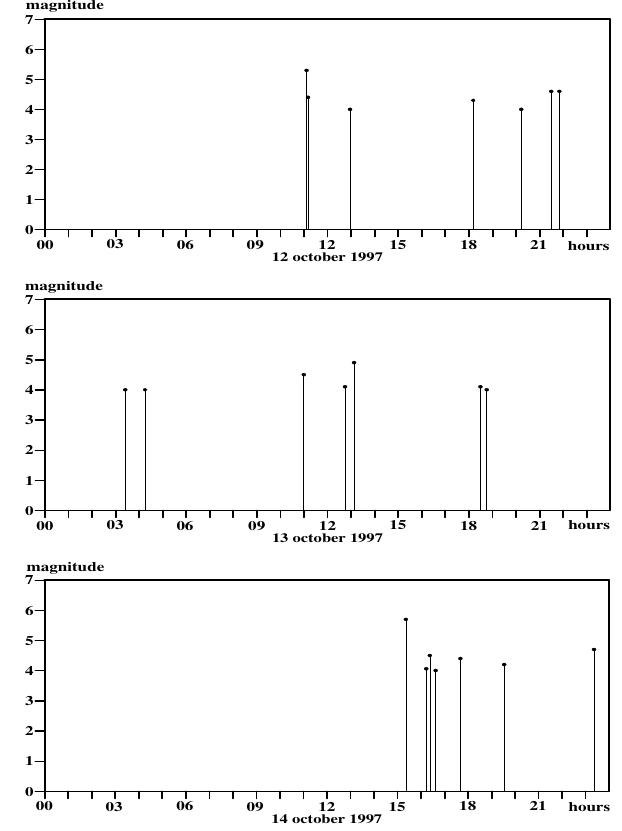
Fig. 4. EQ magnitude distribution on days 12, 13, and 14 Octo- Fig. 4. ber 1997. The strongest EQs occurred on 12 October at 11:08UT, ( M =5.3) and on 14 October at 15:23UT ( M